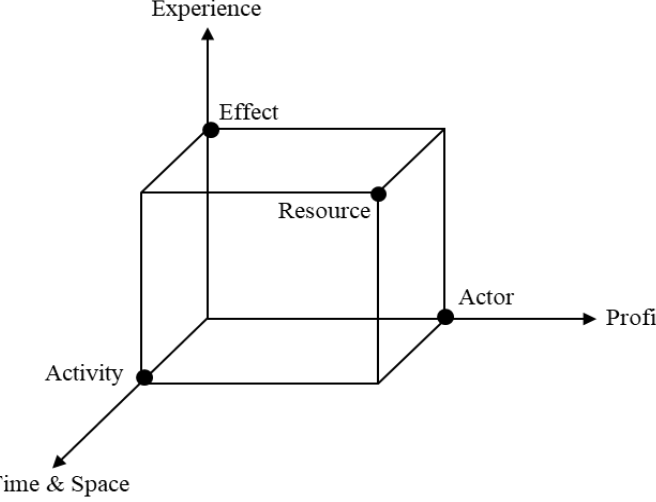
Figure 4. Dimensions of value and resource.